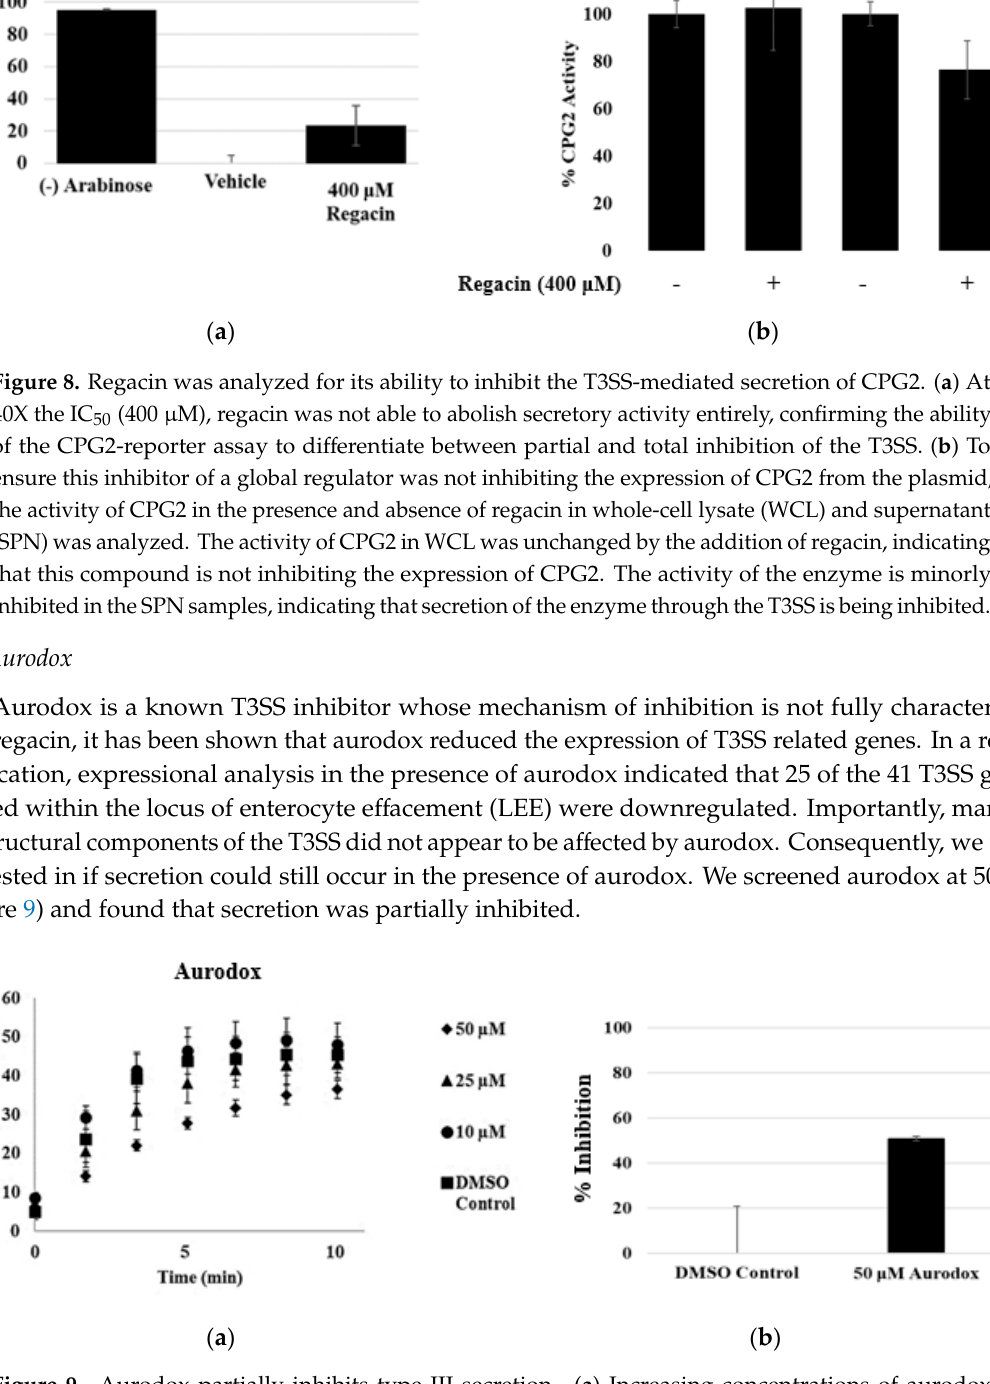
Figure 9. Aurodox partially inhibits type III secretion. ( a ) Increasing concentrations of aurodox results in decreases in secretion of CPG2. ( b ) High concentrations of aurodox (50 µ M, 10 × the IC 50 as determined by hemolysis assays) results in ~30% inhibition of